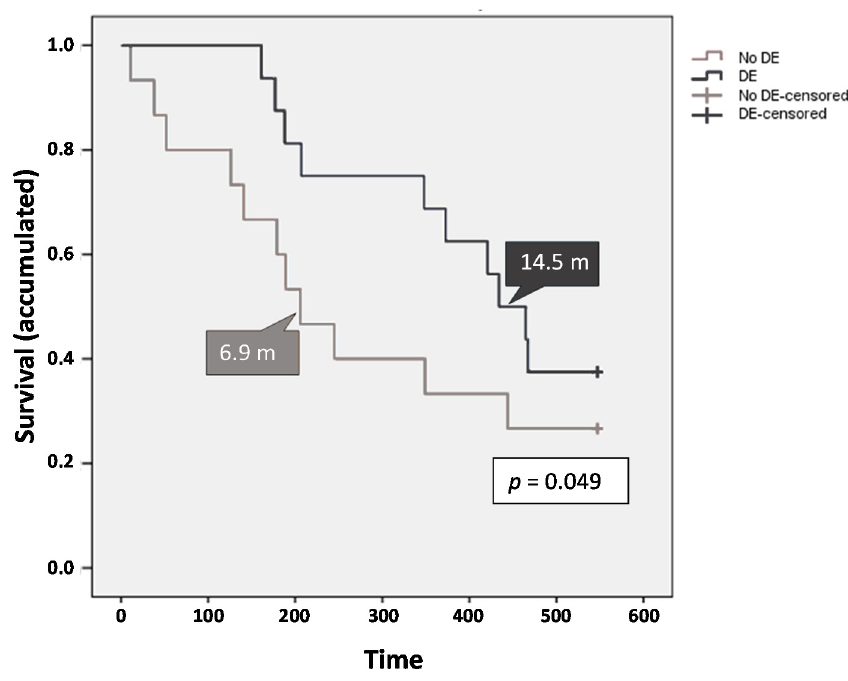
Figure 6. Overall survival according to dermatological toxicity.